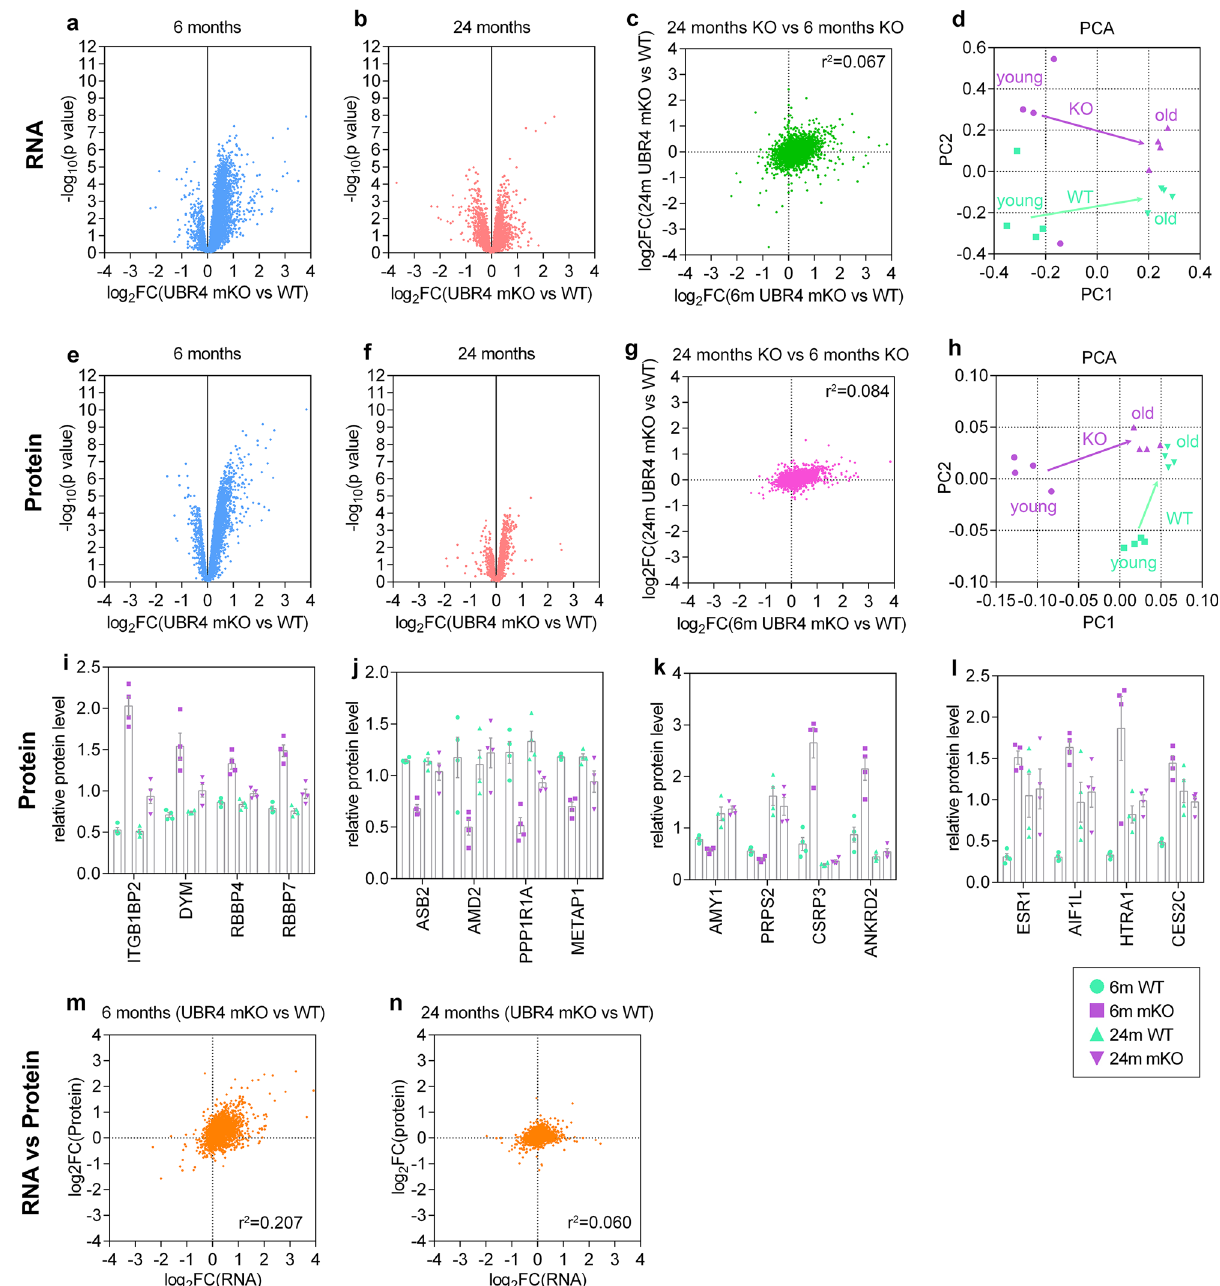
Fig. 2 UBR4 loss causes RNA and protein changes in muscle that are diminished in magnitude with aging. a Volcano plots of RNA changes in UBR4 mKO compared to wild-type controls at 6 months and b 24 months of age. Signi fi cant changes are found in young age but the magnitude of such changes is reduced in old age, as also shown by the direct comparison of logarithmic fold changes between ages ( c ). d Principal component analysis (PCA) shows that old UBR4 mKO and wild-type samples cluster together while at 6 months they are further apart, indicating convergence towards a similar trajectory with aging. e Volcano plots of protein changes in UBR4 mKO compared to wild-type controls at 6 months and f 24 months show large changes in young age but limited changes in old age, as also shown by the direct comparison of log2FC values between ages ( g ). h A similar outcome is found by PCA analyses. i – l Changes in proteins that are unaffected by aging but upregulated with UBR4 mKO with diminishing magnitude in old age ( i ), unaffected by aging but downregulated with UBR4 mKO with diminishing magnitude in old age ( j ), upregulated by aging but downregulated by UBR4 mKO in young but not old age ( k ), and upregulated by aging and by UBR4 mKO in young age ( l ). m , n Comparison of RNA versus protein changes in young ( m ) and old age ( n ) shows decreased correlation between transcription and translation in old age in muscles from UBR4 mKO mice compared to controls. All data are from n = 3 (RNA-seq) and n = 4 (mass spectrometry) individual muscles from independent mice. Data are presented as mean ±